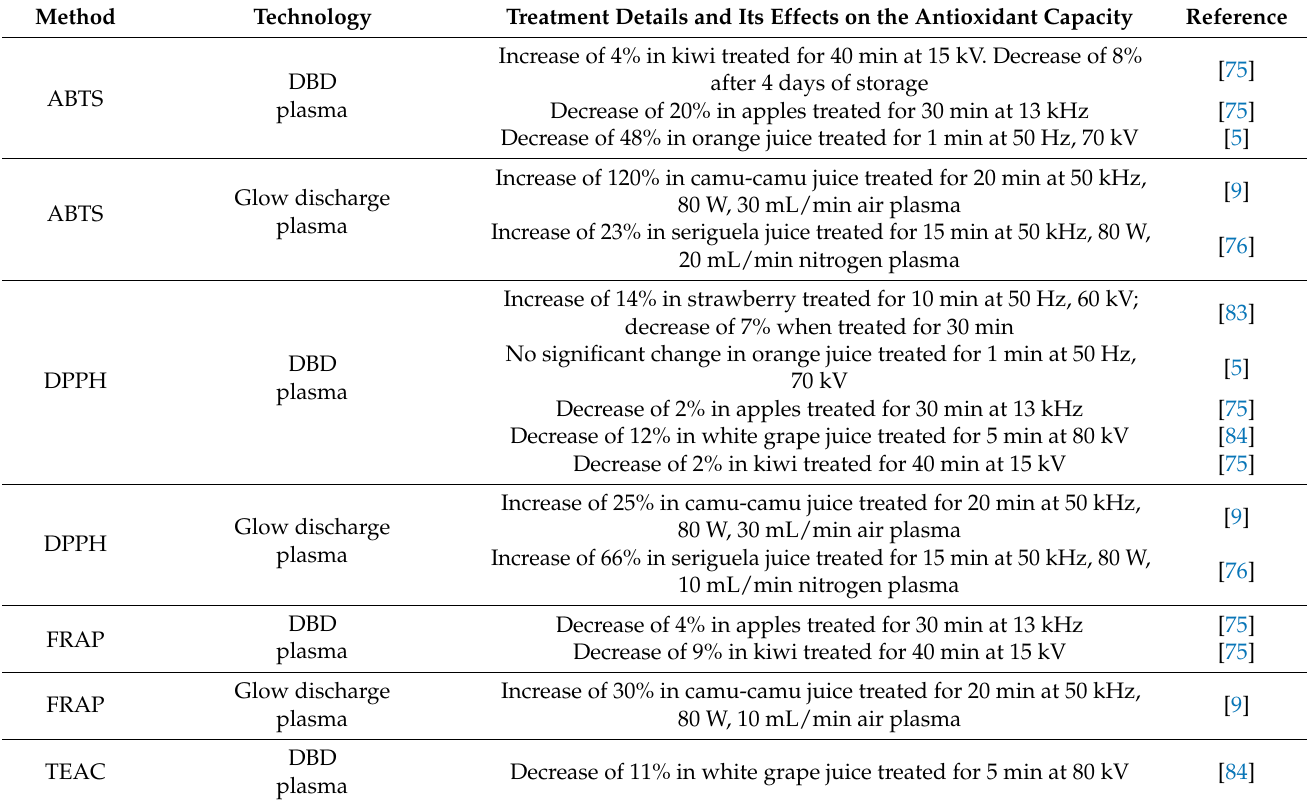
Table 7. Changes in antioxidant capacity induced by cold plasma